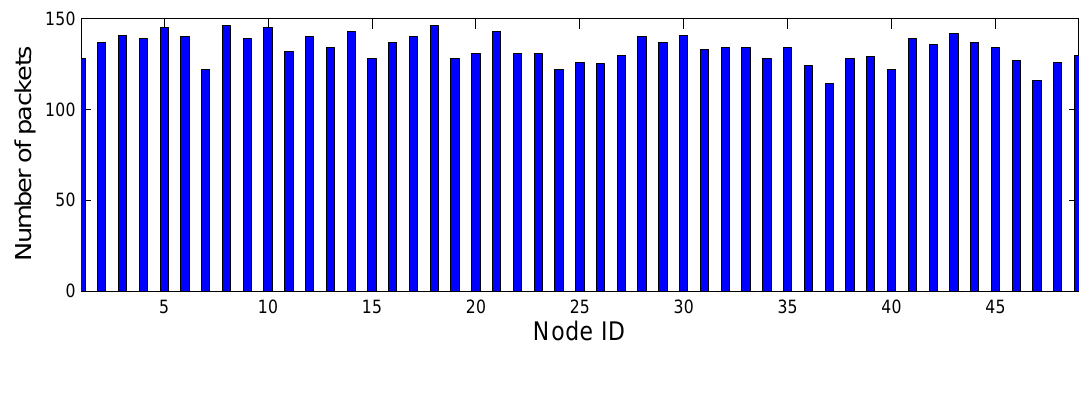
Figure 16. Number of FireSense packets received per node